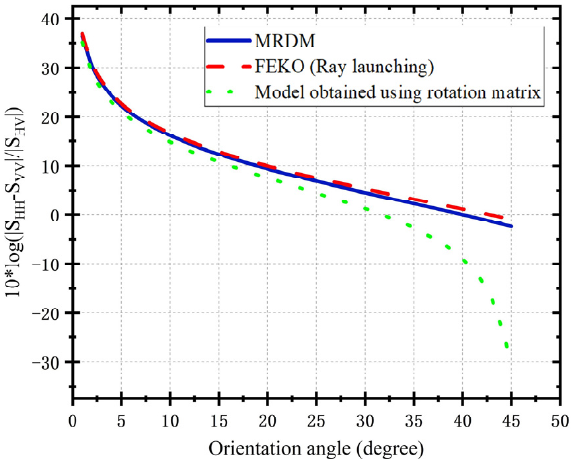
Figure 5. Comparison of parametric scattering model with different orientation angles.